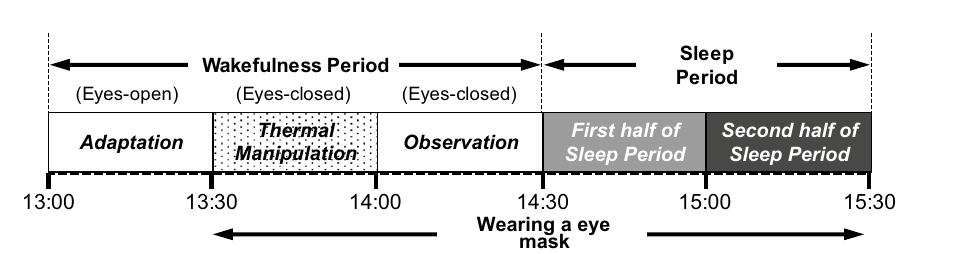
Figure 5. Correlation between sleep onset latency (SOL) and distal–proximal skin temperature gradient (DPG) in the ( a ) sham condition and ( b ) warming conditions. X axis represents the DPG just before the sleep period. n.s.; not significant.